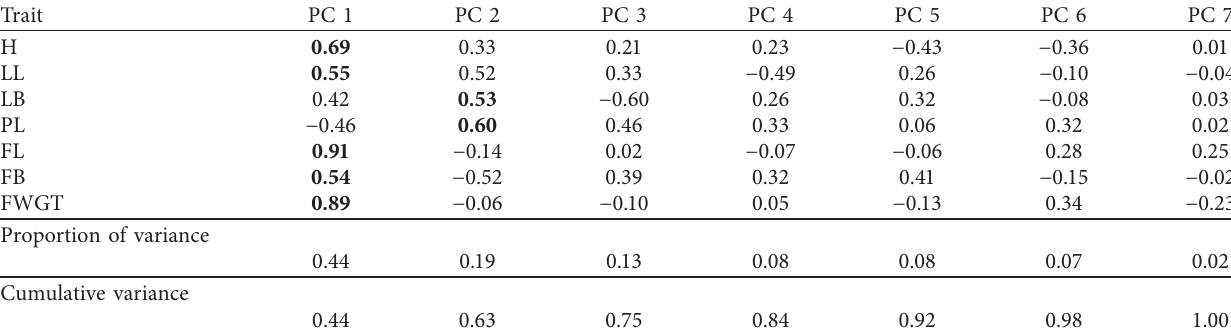
Table 8: Variability of the principal component analysis of quantitative traits of doum palm in Kenya. Trait PC 1